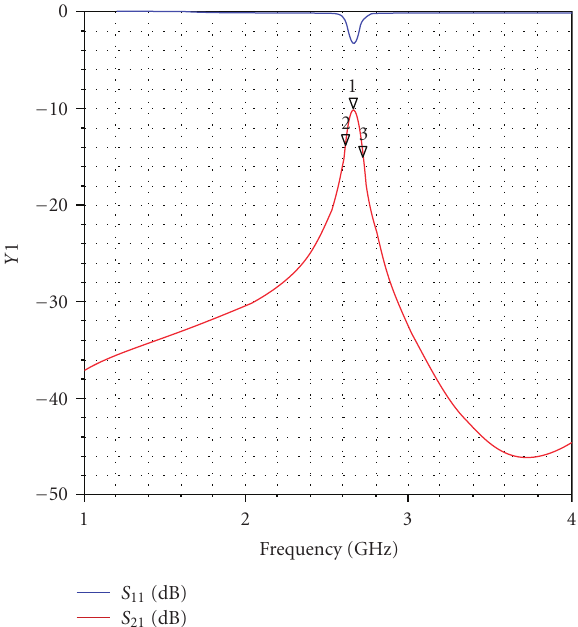
Figure 11: Simulated response of single hair-pin resonator filter with capacitive